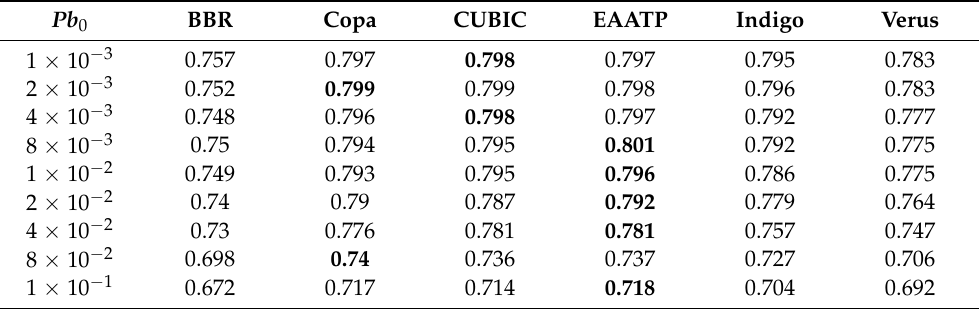
Table 4. Best STR achieved by each transport protocol in the “5 redundant sensors × 16 clusters” case. The best STR for each Pb 0 is highlighted in